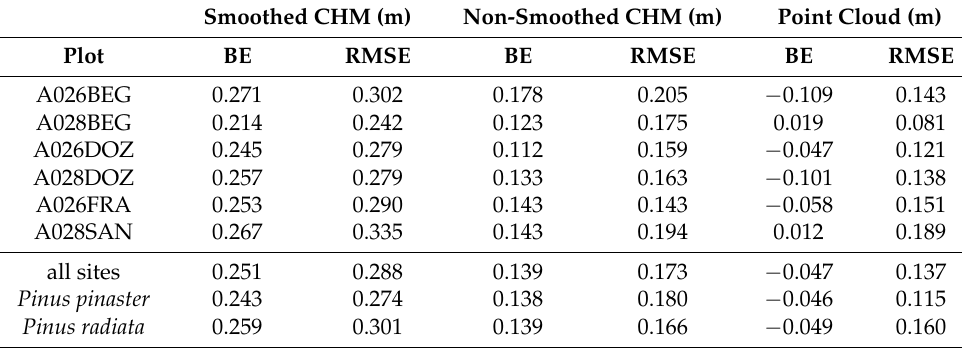
Table 6. Goodness-of-fit statistics obtained from the well-identified trees by the Dalponte and Coomes [42] algorithm and their respective field-measured values (BE represents the mean bias error; RMSE represents the root mean square error, both in m).